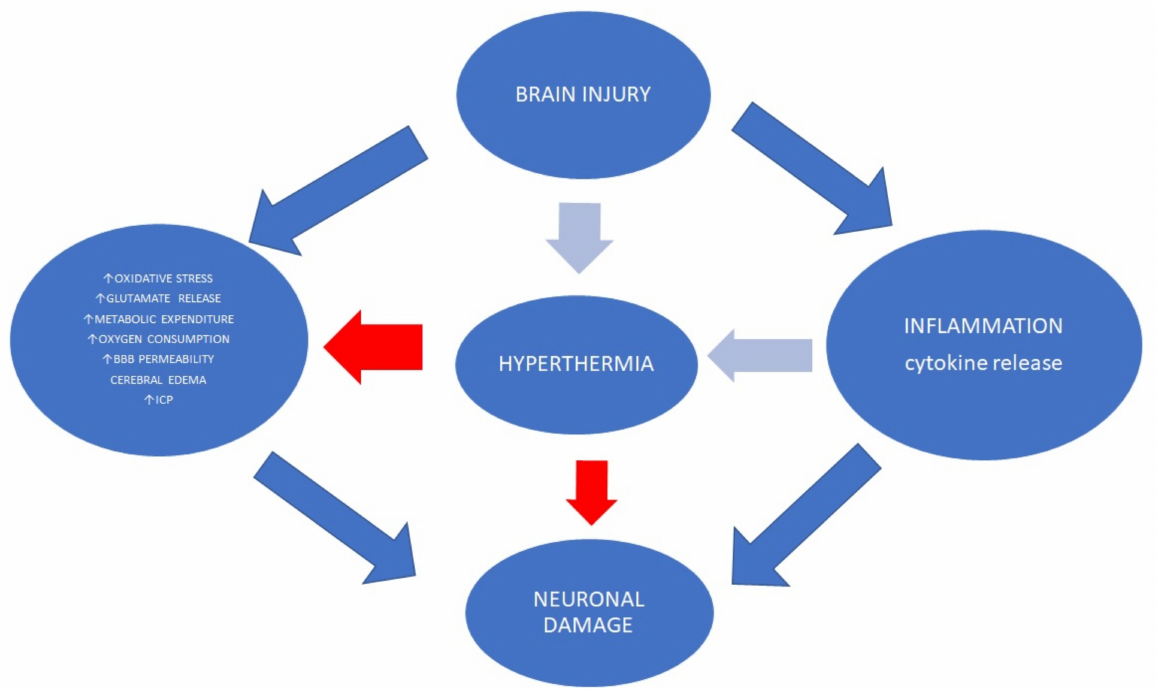
Figure 2. Hyperthermia is associated with poor neurological outcomes because it predisposes to greater secondary damage. Temperature changes lead to elevation of cytokine release, higher neutrophil activity and elevated metabolic expenditure. Hyperthermia also increases ROS generation and